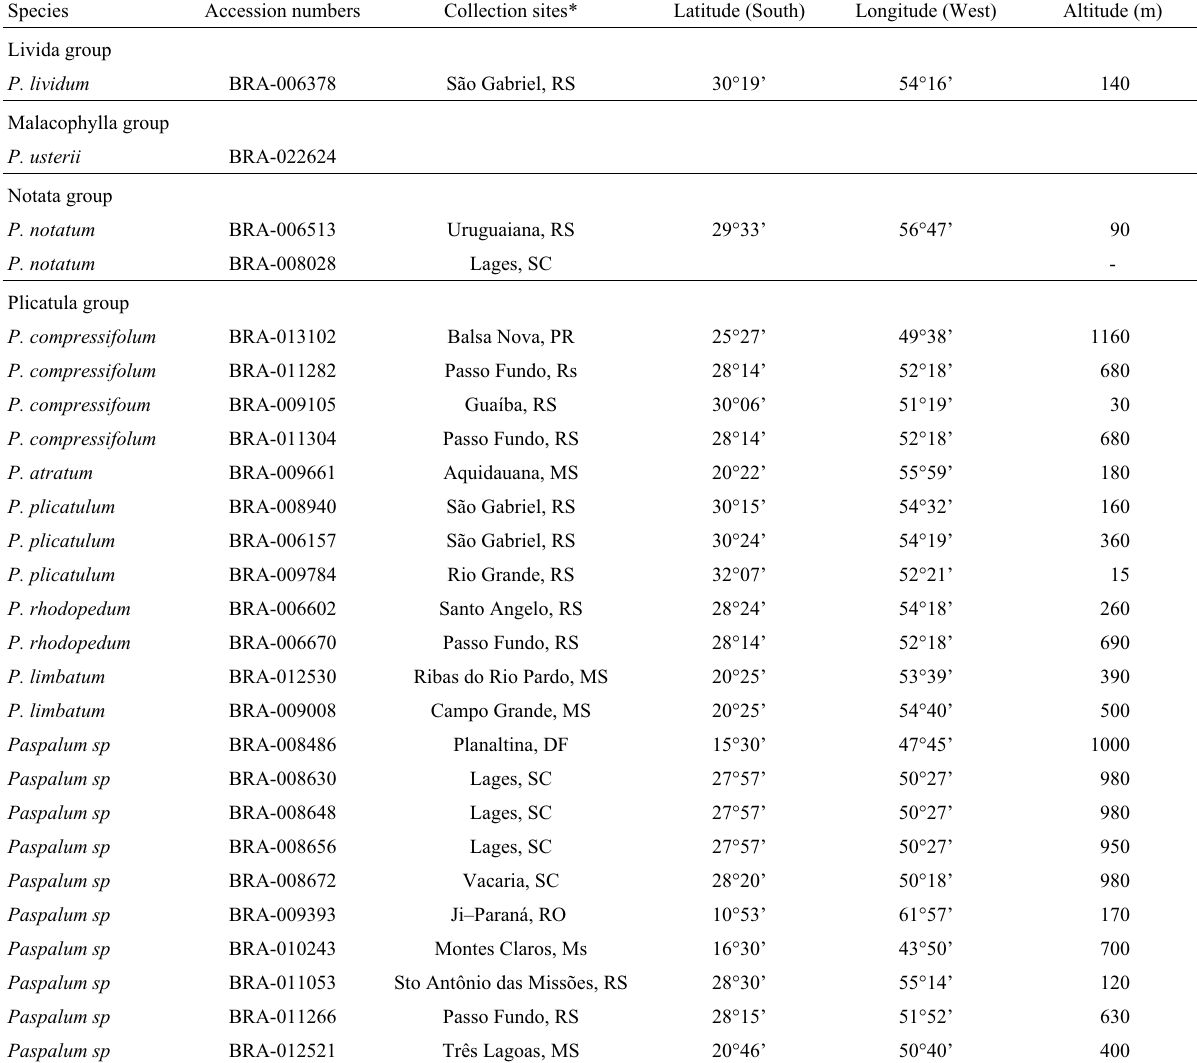
Table 1 - Species investigated in the present study with their accession numbers and collection site